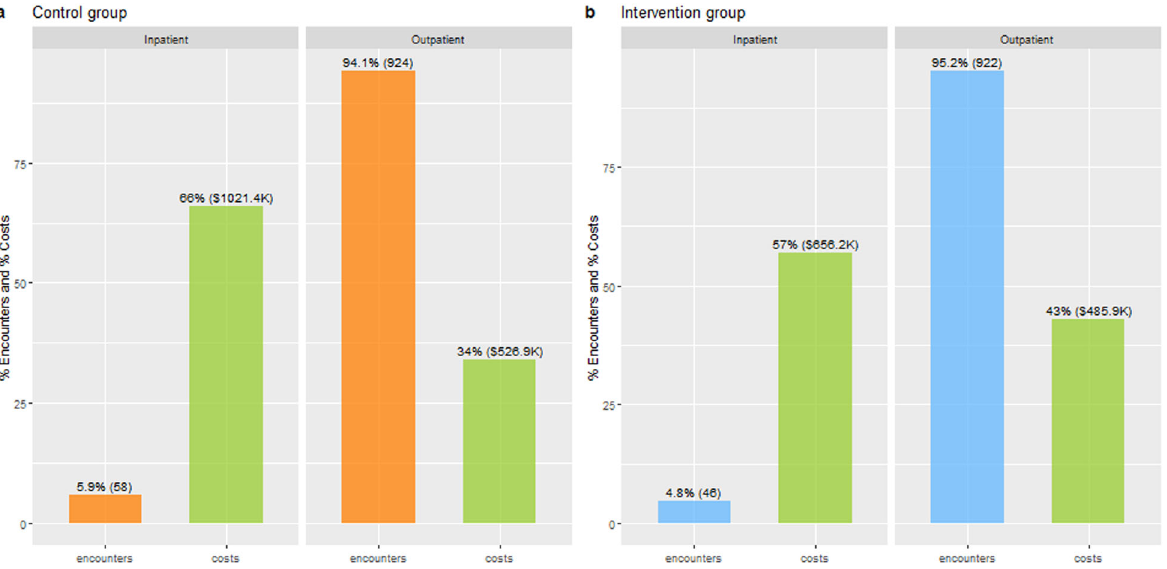
Fig. 3 Distributions of the inpatient and outpatient encounters and their costs in the control group ( a ) and the intervention group ( b